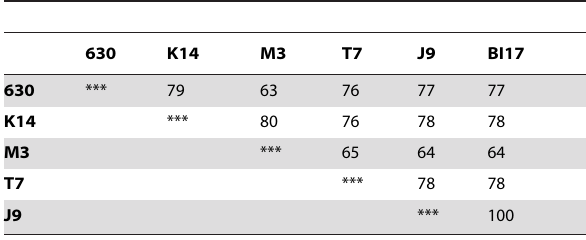
Table 3. SlpA High Molecular Weight (HMW) subunit sequence